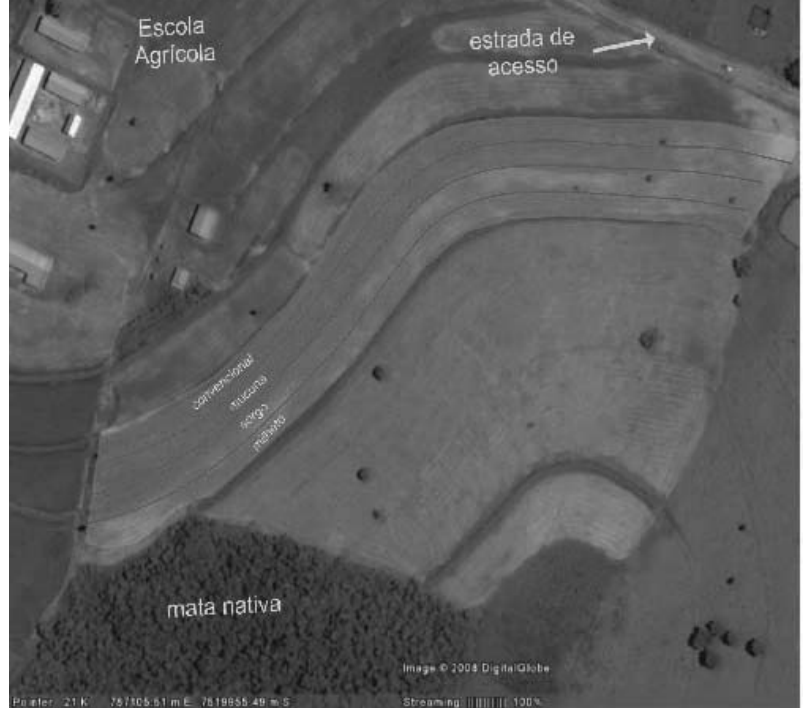
Figura 1. Imagem das áreas com fragmento da vegetação nativa e campo experimental, localizado